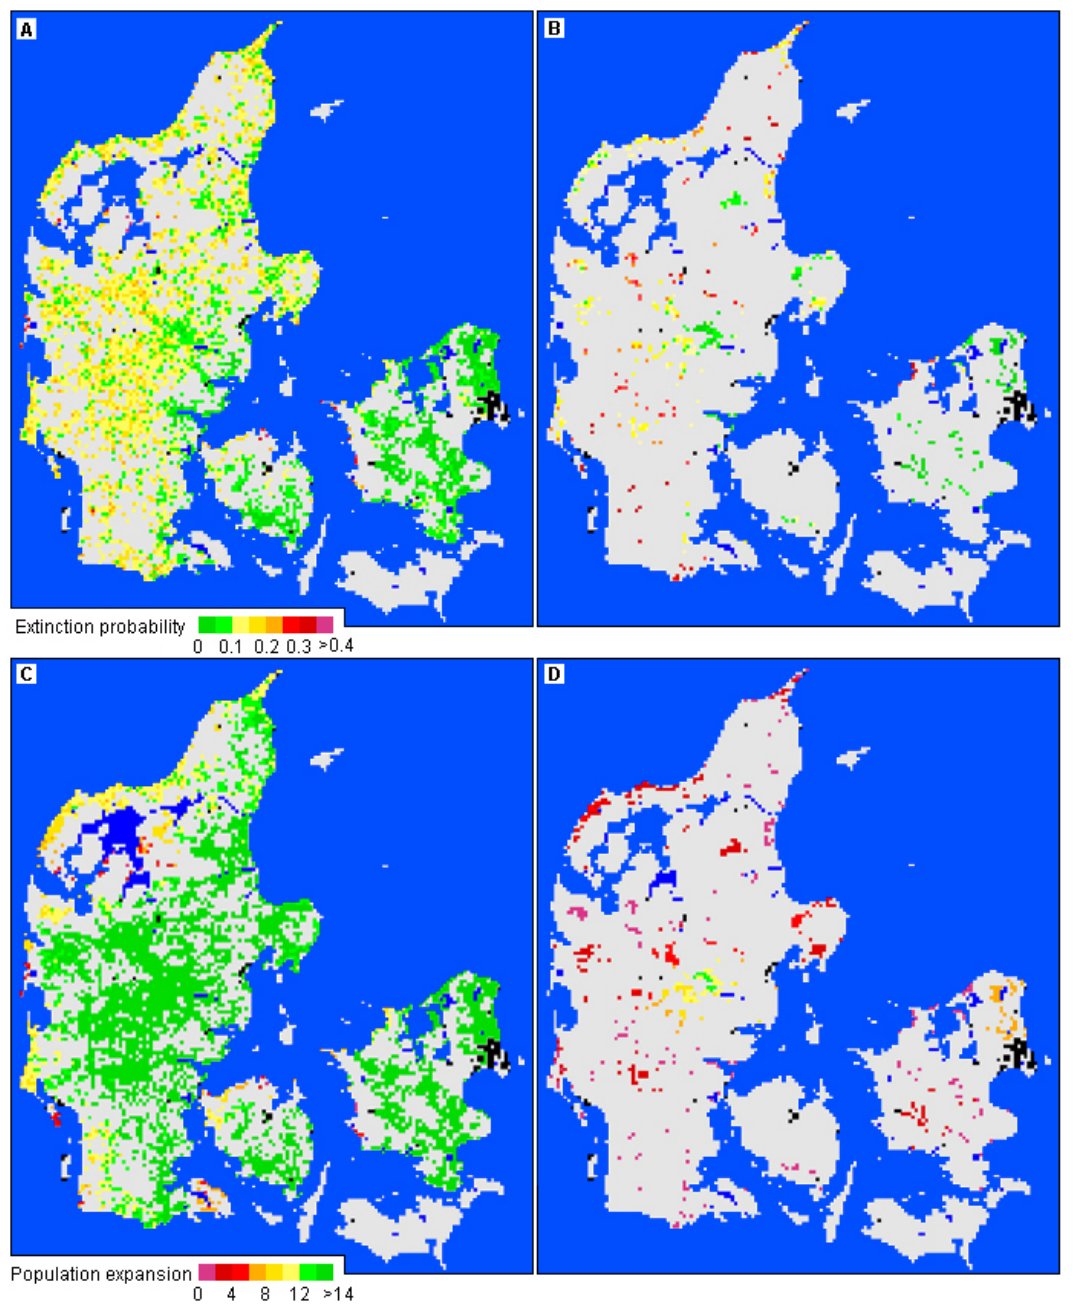
Fig. 3 . Extinction probability from 0 to 1 and expected population expansion, i.e., number of cells colonized divided by five or the number of release cells, for releases in each focal wild boar reintroduction cell in Denmark. Maps A and C assume that cells with ‡ 10% forest provide breeding habitat to wild boars; in B and D, only cells with ‡ 50% forest are